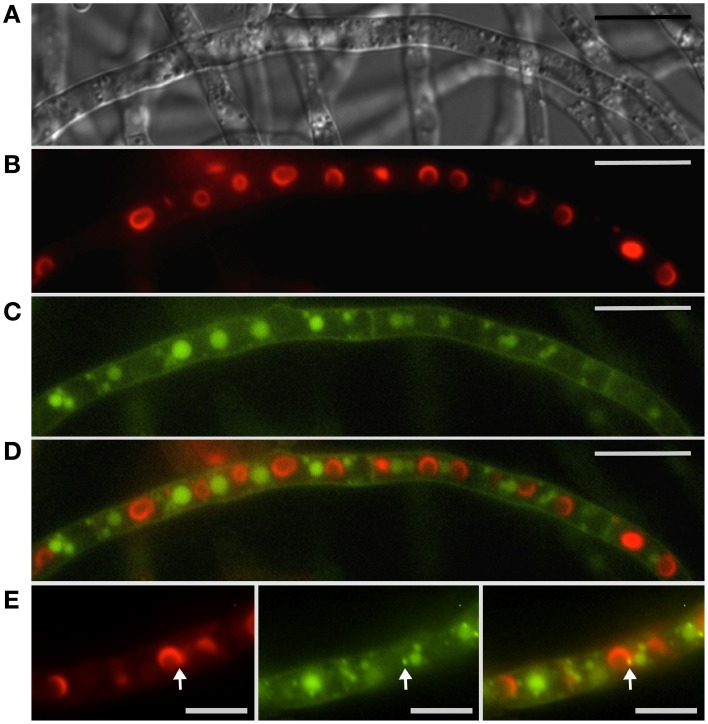
Interaction between toxisomes and motile Tri12p containing vesicles. Toxisomes, vacuoles and motile vesicles are visualized in a strain of F. graminearum having a GFP-tagged Tri12p and a TagRFP-T-tagged trichodiene oxygenase. (A) Hyphae visualized using DIC microscopy. (B) TagRFP-T-tagged trichodiene oxygenase fluorescence at the periphery of toxisomes. (C) GFP-tagged Tri12p localizes to vacuoles and smaller motile vesicles (see also Supplemental Video S2). (D) Overlay of B and C showing alternate arrangement of vacuoles and toxisomes. Bar = 10 μM. (E) Closer view of (left to right) TagRFP-T-tagged trichodiene oxygenase, GFP-tagged Tri12p and overlay. Bar = 5 μm. Note transient co-localization of motile vesicle and toxisome (arrow). Movement of Tri12p vesicles between the toxisome and vacuole as well as fusion of vesicles with the plasma membrane and vacuoles are illustrated in the Supplemental Video S2. Results presented in Menke et al. (2013); figure generated for Menke (2011).